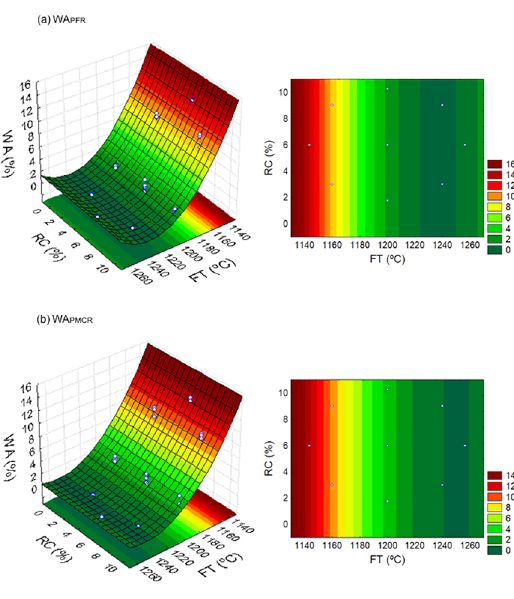
Figure 4. Response surface of the variable WA, for the compositions: (a) PFR and (b) PMCR.